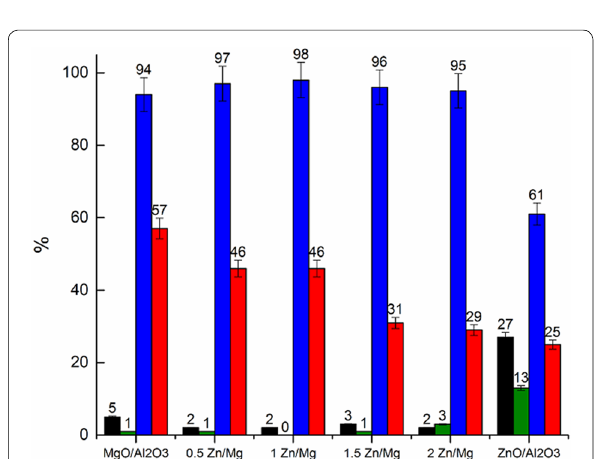
Fig. 7 Selectivity to monoglycerides (black square), diglycerides (green square) and FAME (blue square), and FAME yield (red square) obtained for each catalyst, in the transesterification of castor oil with